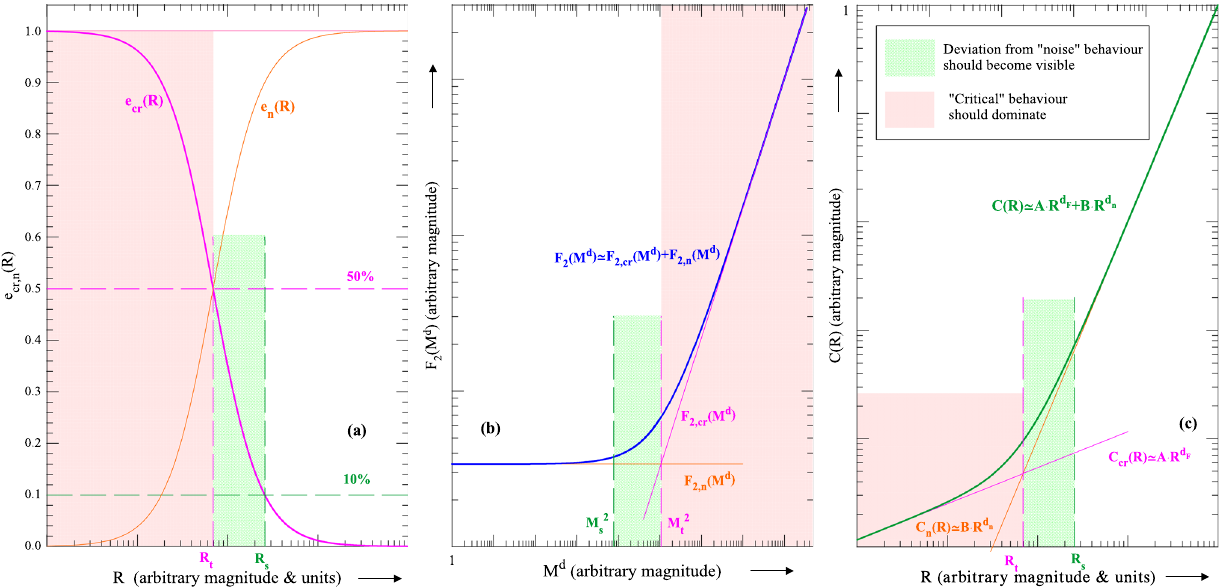
Fig. 14 Qualitative description of the behaviour of the estimators e cr ( R ) , e n ( R ) ( a ), the factorial moments F 2 ( b ) and the correlation integral C ( c ), in a case where a system with high percentage of noise is analysed